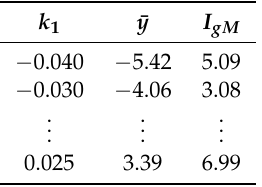
Table 1. Table of Values for R D =40 Ω .